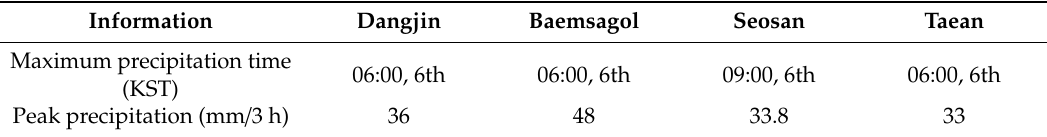
Table 8. Rainfall information of the four sites from the observational data.